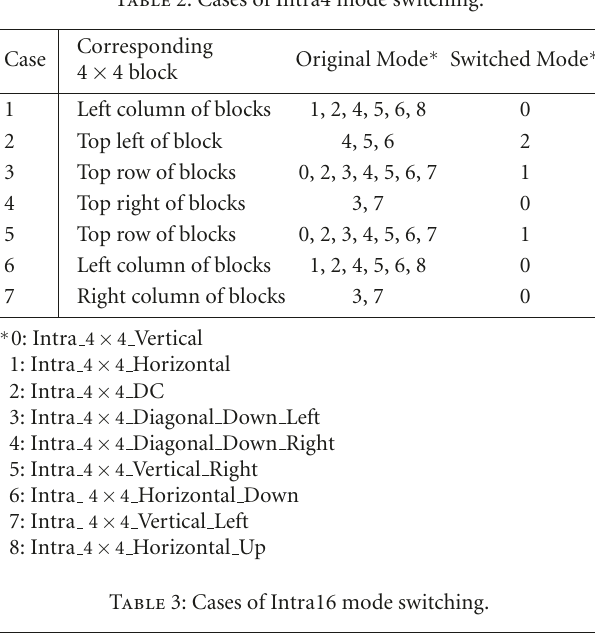
Figure 9: Relative position of each case in intramode switching method. Table 2: Cases of Intra4 mode switching.